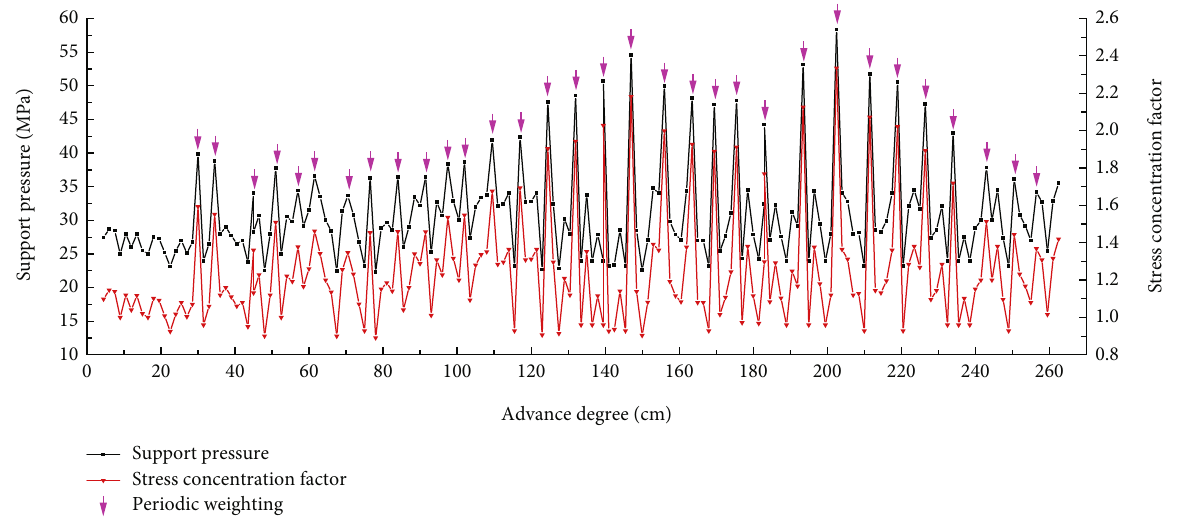
Figure 18: Support pressure and stress concentration coe ffi cient in the 2301 working face.